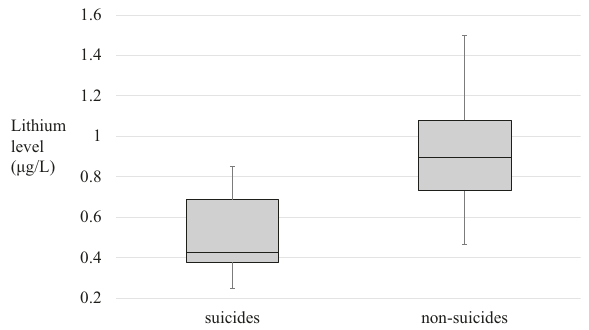
Fig. 1 Aqueous humor lithium levels in suicides and